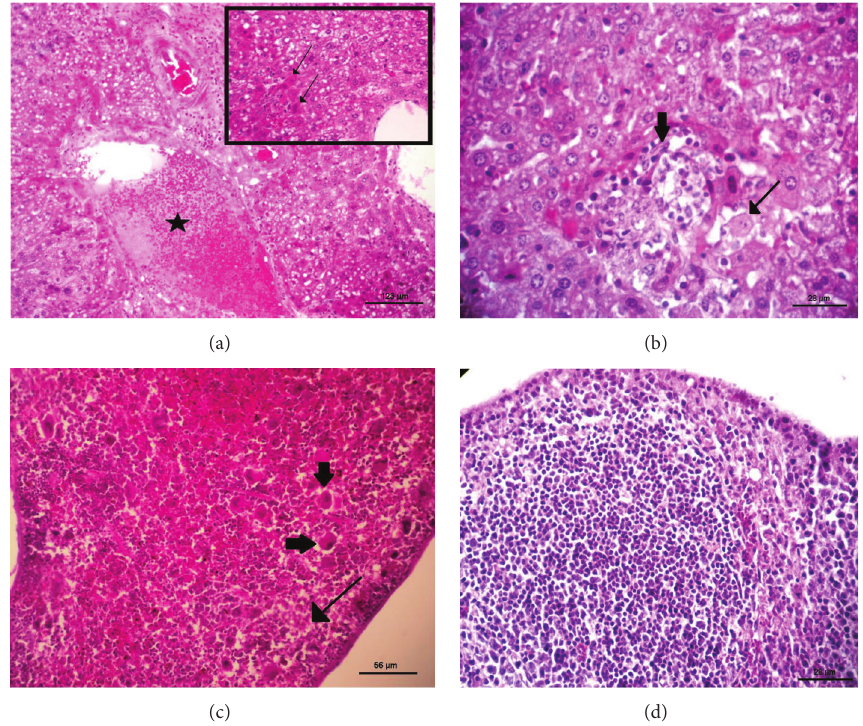
Figure 2: Histologic pattern of the liver and spleen of mice pretreated with P1G10 72 hours after infection by Salmonella Typhimurium. (a) Liver of mice in the PBS group, showing severe vacuolation, necrosis of individual hepatocytes with diffuse distribution (thin arrow), and thrombosis (star); (b) liver of mice in the experimental group (P1G10, 10 mg/Kg), demonstrating hepatic necrosis (thin arrow) and accumulation of mononuclear cells (large arrow); (c) spleens of mice in the control group, showing lymphoid depletion (thin arrow) and the presence of giant cells (large arrow); (d) spleens of mice in the experimental group with preserved appearance of the white pulp and red